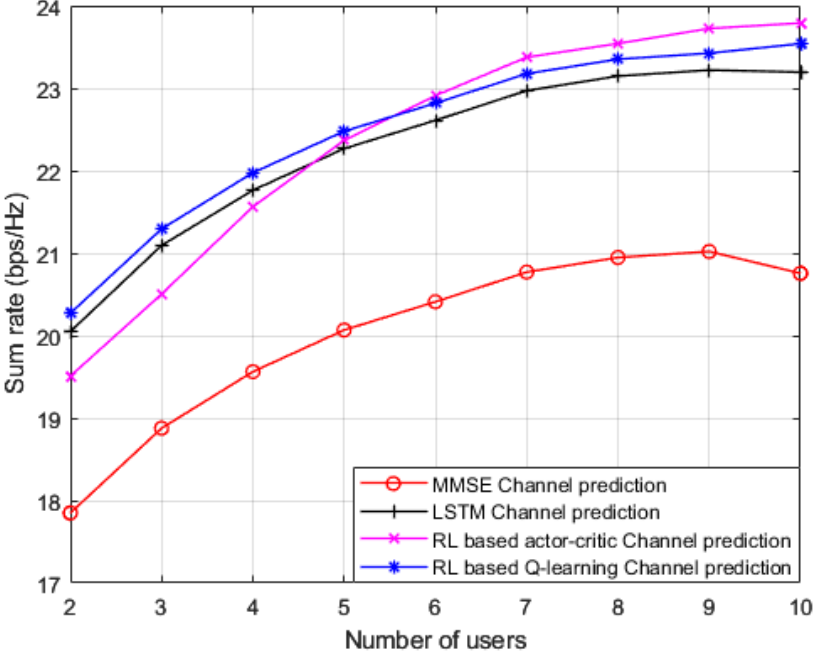
Figure 6. Sum rate vs. power (MMSE, LSTM, RL actor ‐ critic, RL Q ‐ learning).